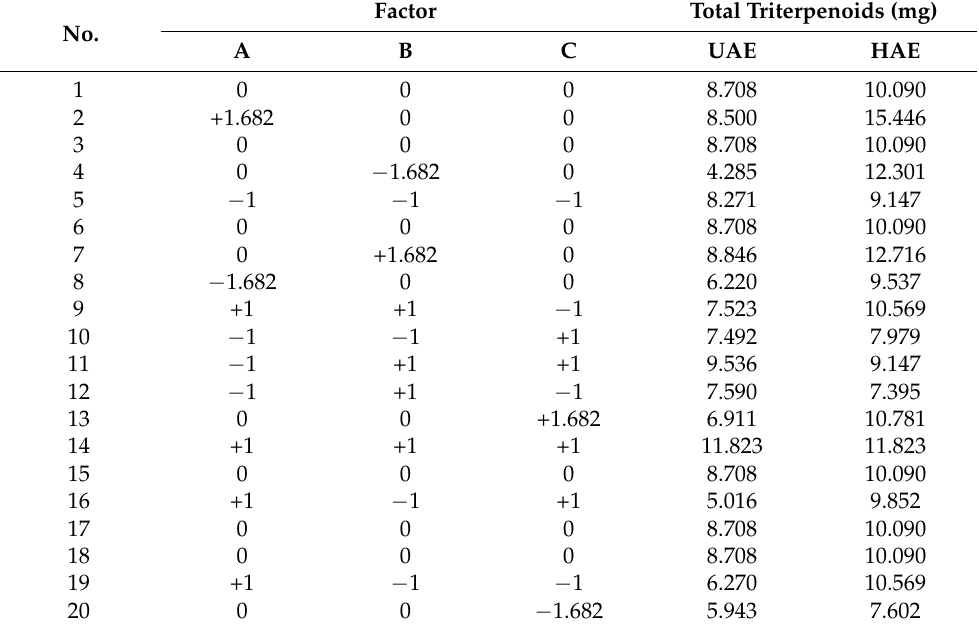
Table 1. Central composite design and indicator